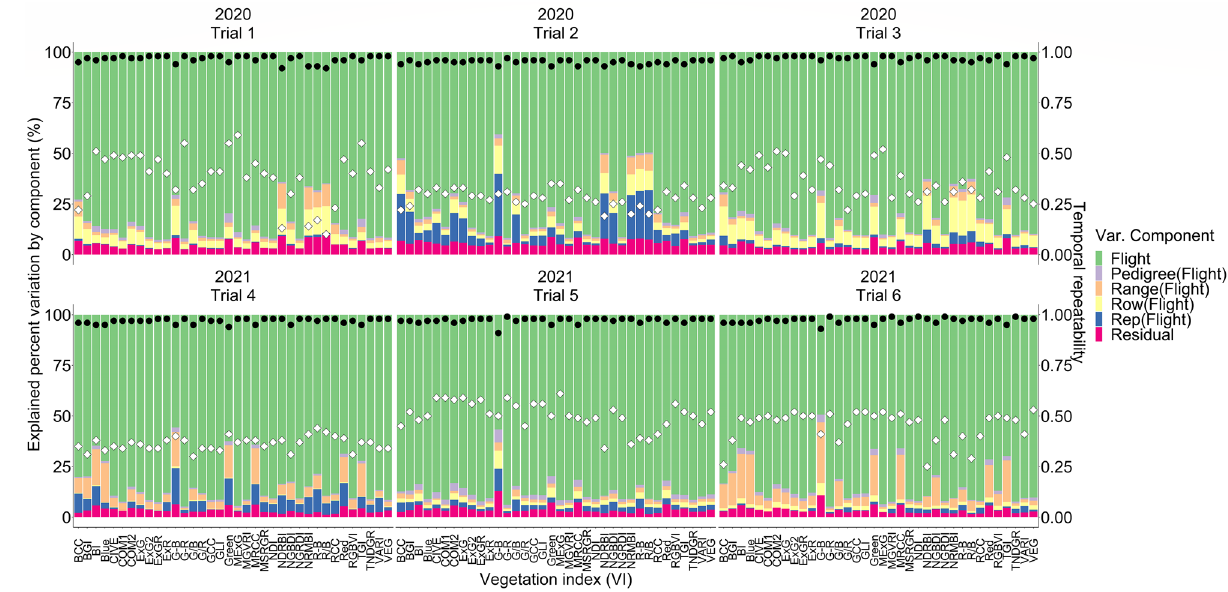
Figure 3. The explained percent variation by each component in nested design [Eq. (1)] was illustrated by a stacked bar plot. Left Y axis shows the explained percent variation by each component in nested design, the X axis shows the VIs for each trial and year. Right Y axis shows the scale for R-squared and temporal repeatability. Black circles indicate R-squared and white diamonds indicate temporal repeatability.